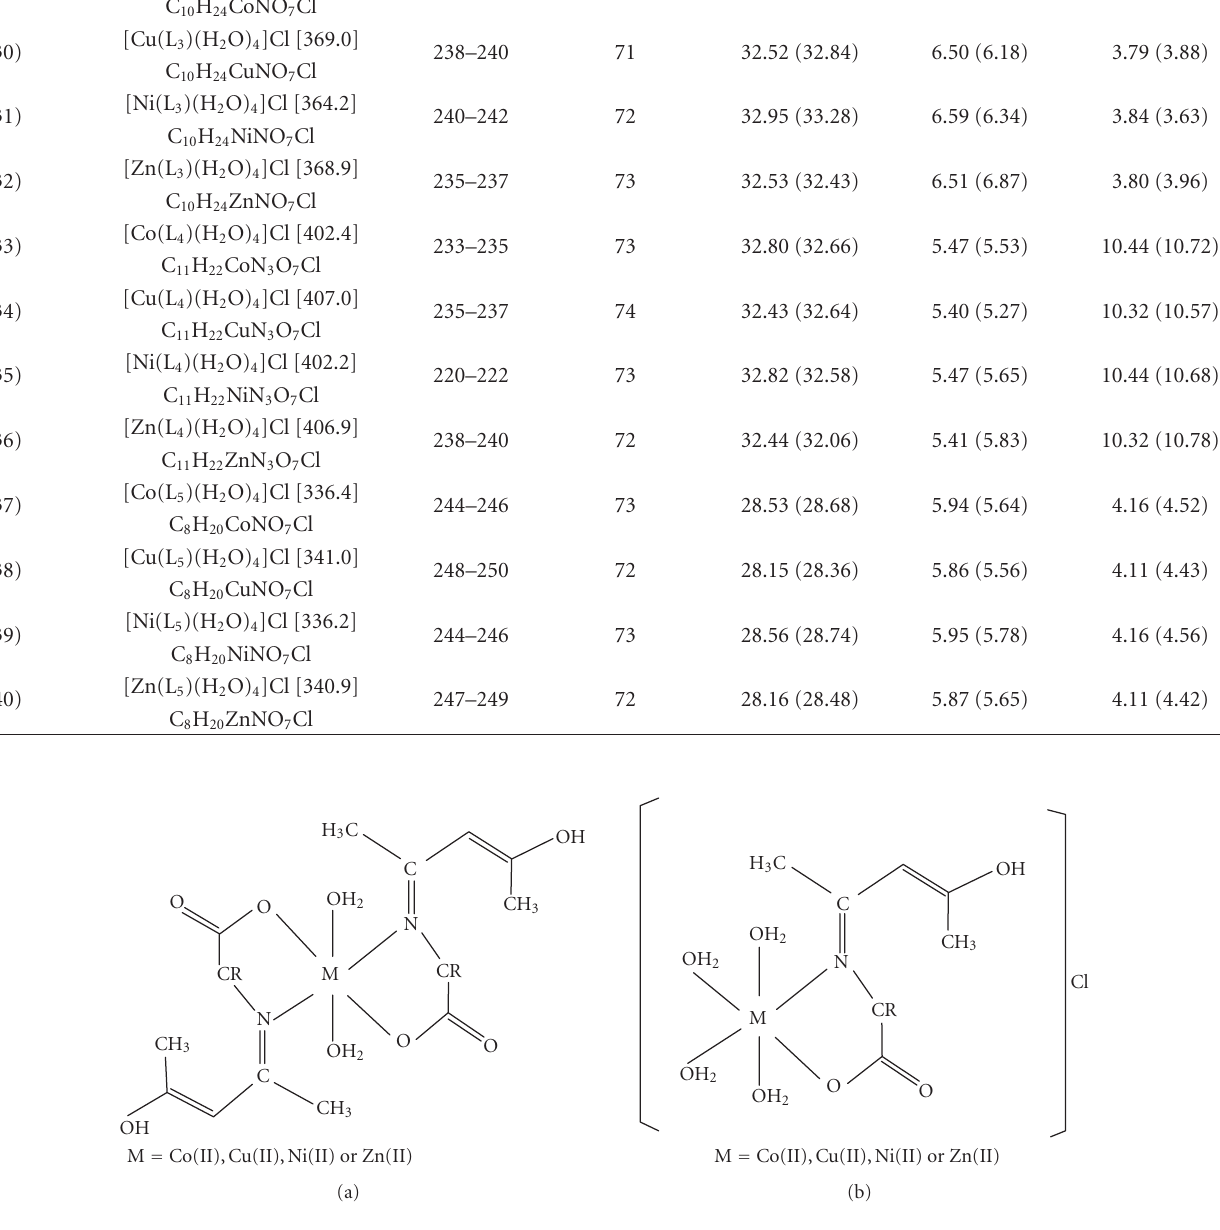
Figure 2: Proposed structures of the metal(II) complexes